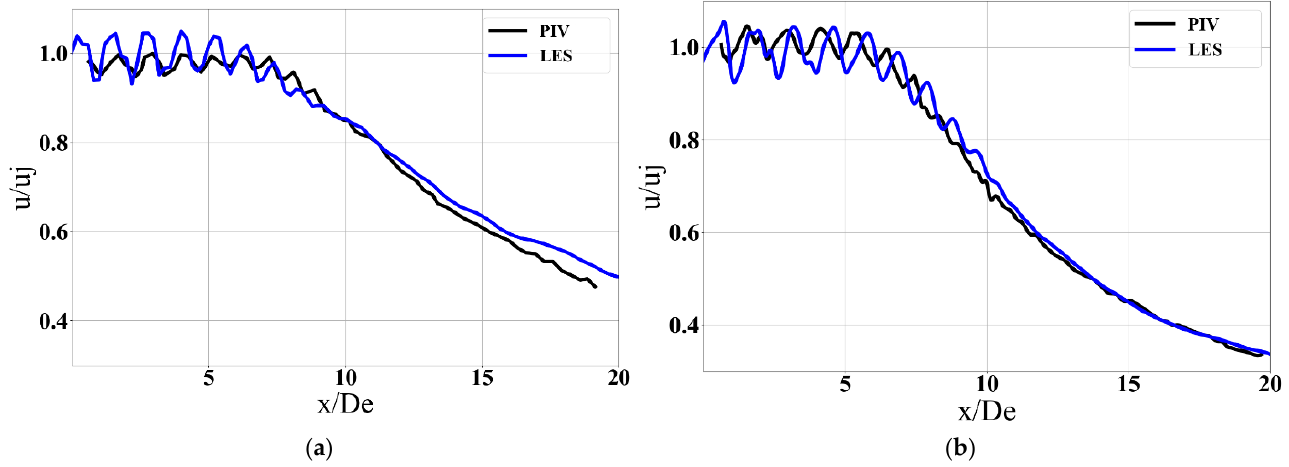
Figure 3. Normalized (by 𝑢 (cid:3037) ) jet centerline velocity comparison with PIV experimental data from Baier et al. [45]. ( a ) LEScold, ( b ) LEShot.